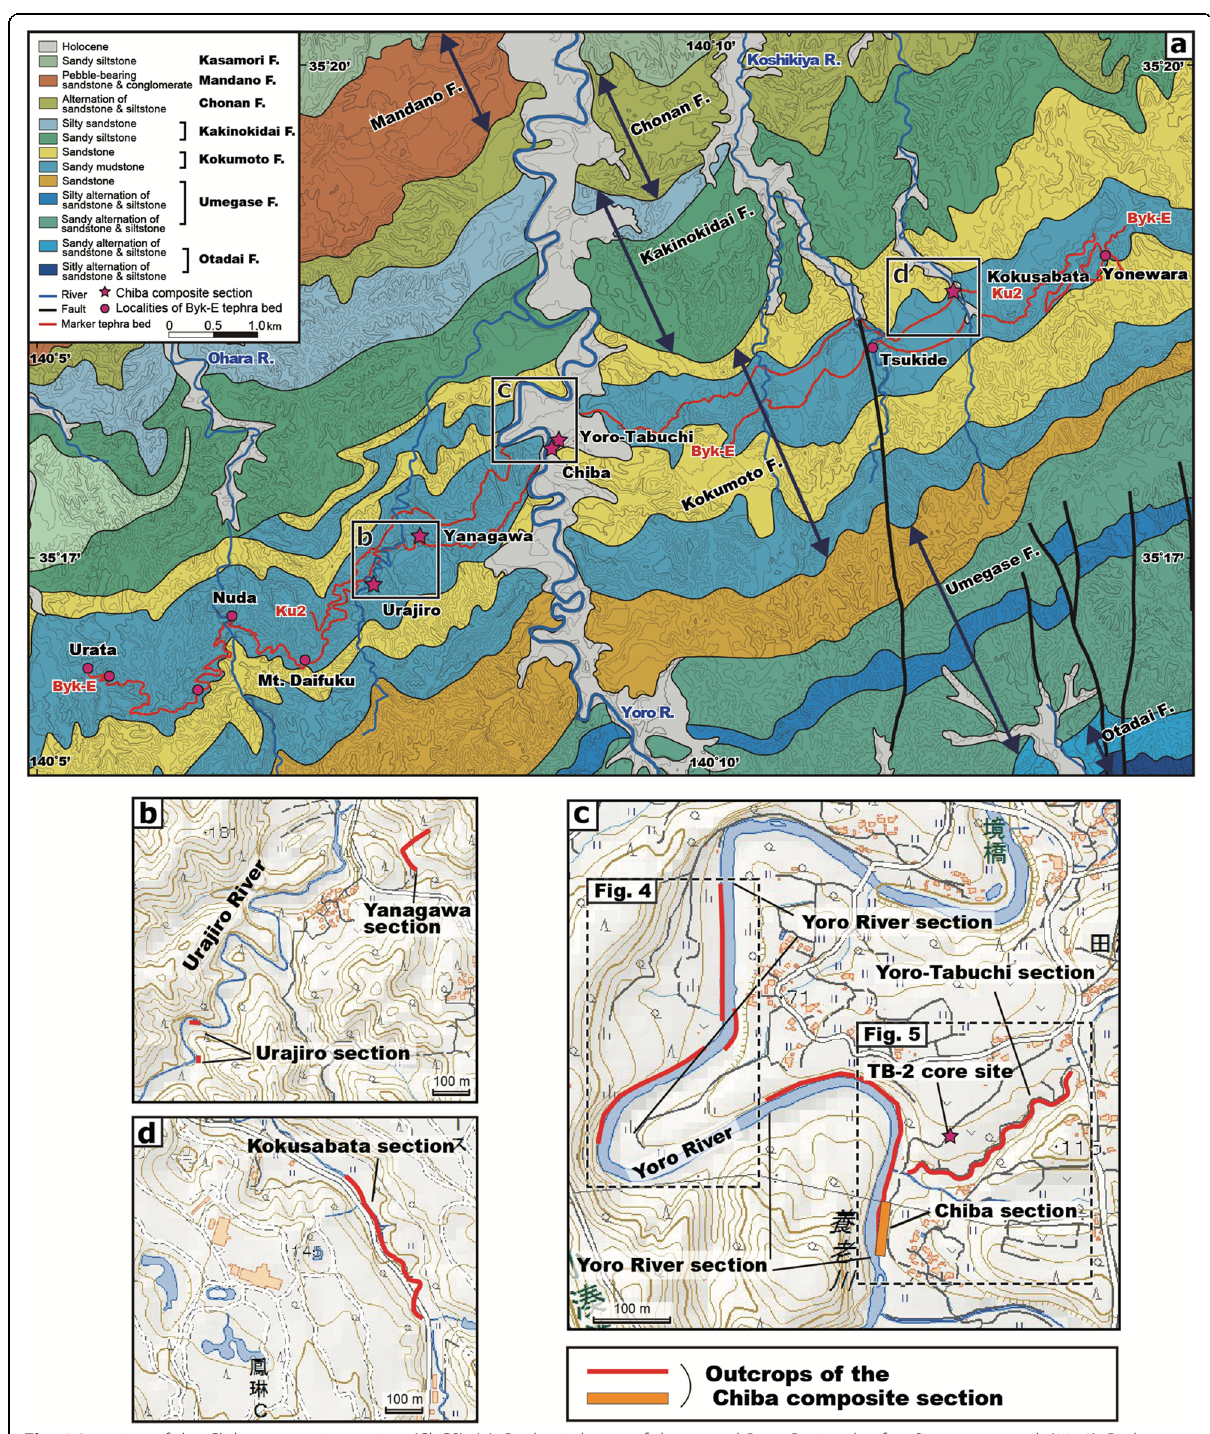
Fig. 2 Location of the Chiba composite section (CbCS): ( a ) Geological map of the central Boso Peninsula after Suganuma et al. (2018). Red stars indicate locations of the sub-sections of the CbCS; ( b ) – ( d ) Detailed maps of the sub-sections of the CbCS, as indicated by the black squares in ( a